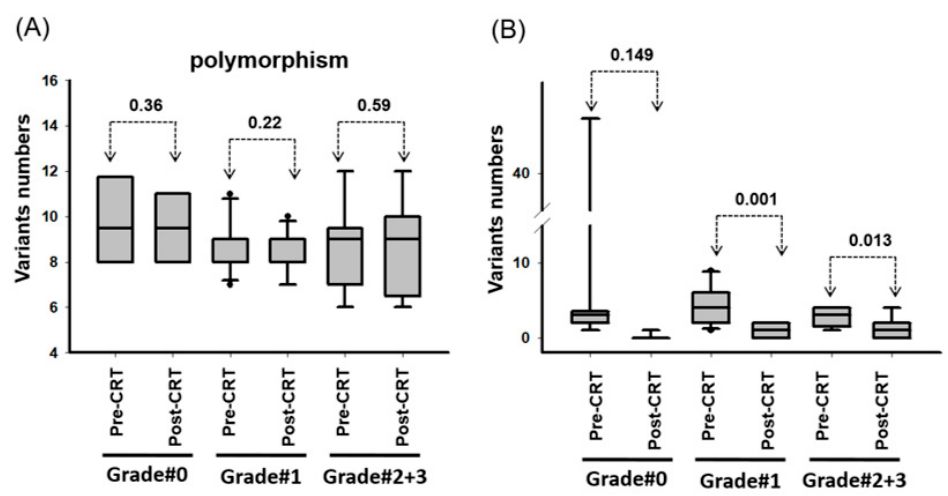
Figure 2. Genetic variants were analyzed in biopsy specimens from 29 patients with rectal carcinoma before and after nCRT. ( A ) The number of genes with polymorphisms were detected in an individual patient before and after nCRT. ( B ) The numbers of gene mutations were detected in an individual patient before and after nCRT. The variants with an allelic frequency of >5% and a variant count of >25 were included.